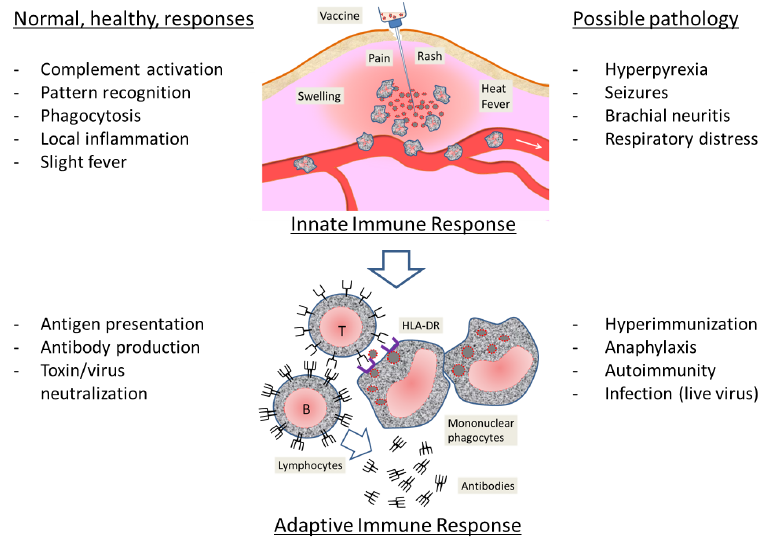
Figure 1. Innate and adaptive responses to a vaccine. Left column: normal responses; right column: possible pathology (excess/disorder of biological responses). Image is author’s own, produced for this